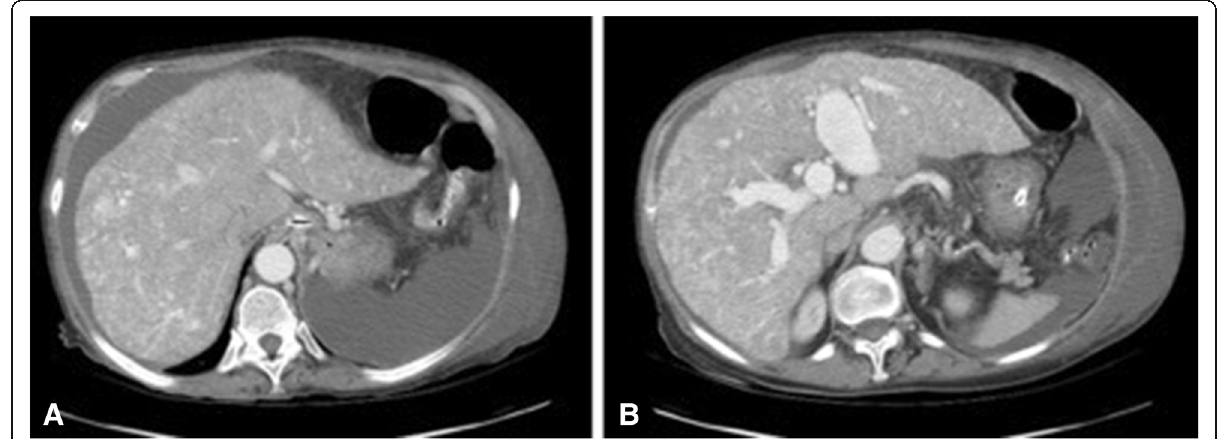
Fig. 8 A and B Axial CT images with contrast of a 77-year-old female with HHT and portal hypertension showing cirrhotic features due to pseudocirrhosis. Findings consistent with HHT and portal hypertension including ascites, hypertrophy of the caudate lobe, portal venous enlargement, and